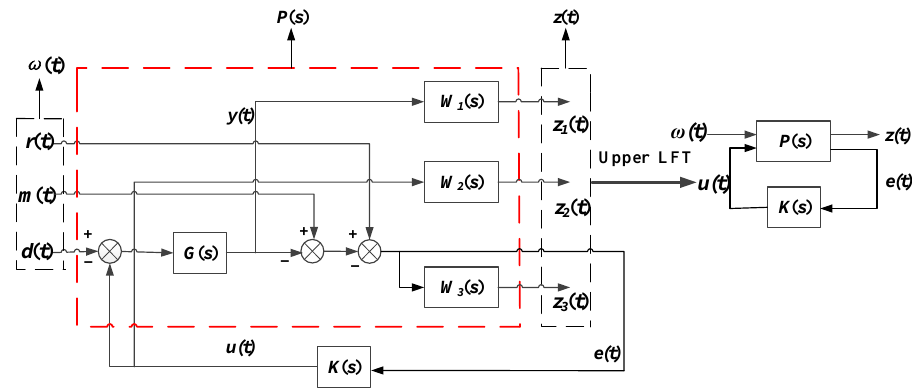
Figure 4. Structures of the mixed-sensitivity problem and the standard H∞ control .